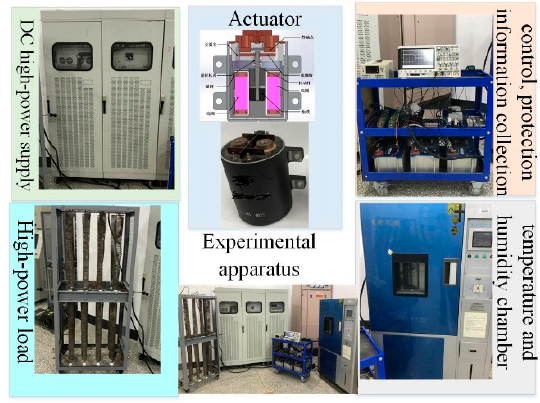
Figure 11. The experimental apparatus.